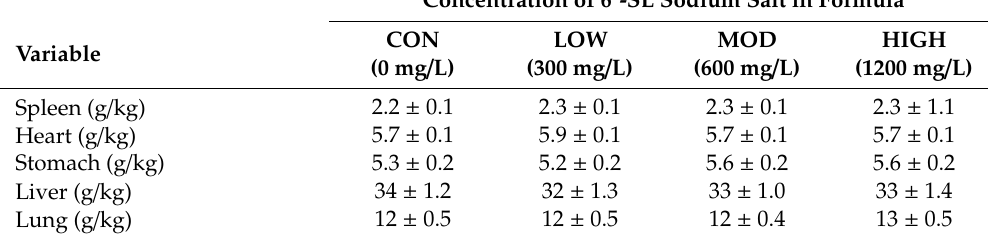
Table 1. Cont. Concentration of 6 (cid:48) -SL Sodium Salt in Formula